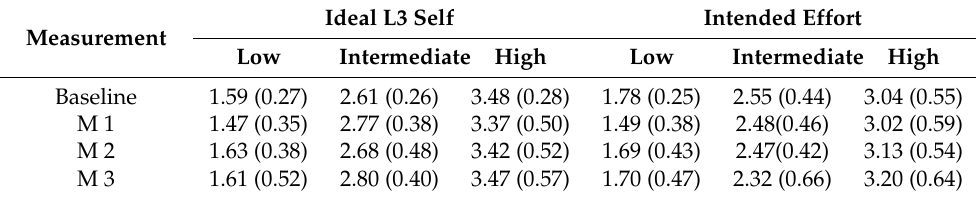
Table A3. Mean and SD for ideal L3 self and intended effort according to level of IL3S.